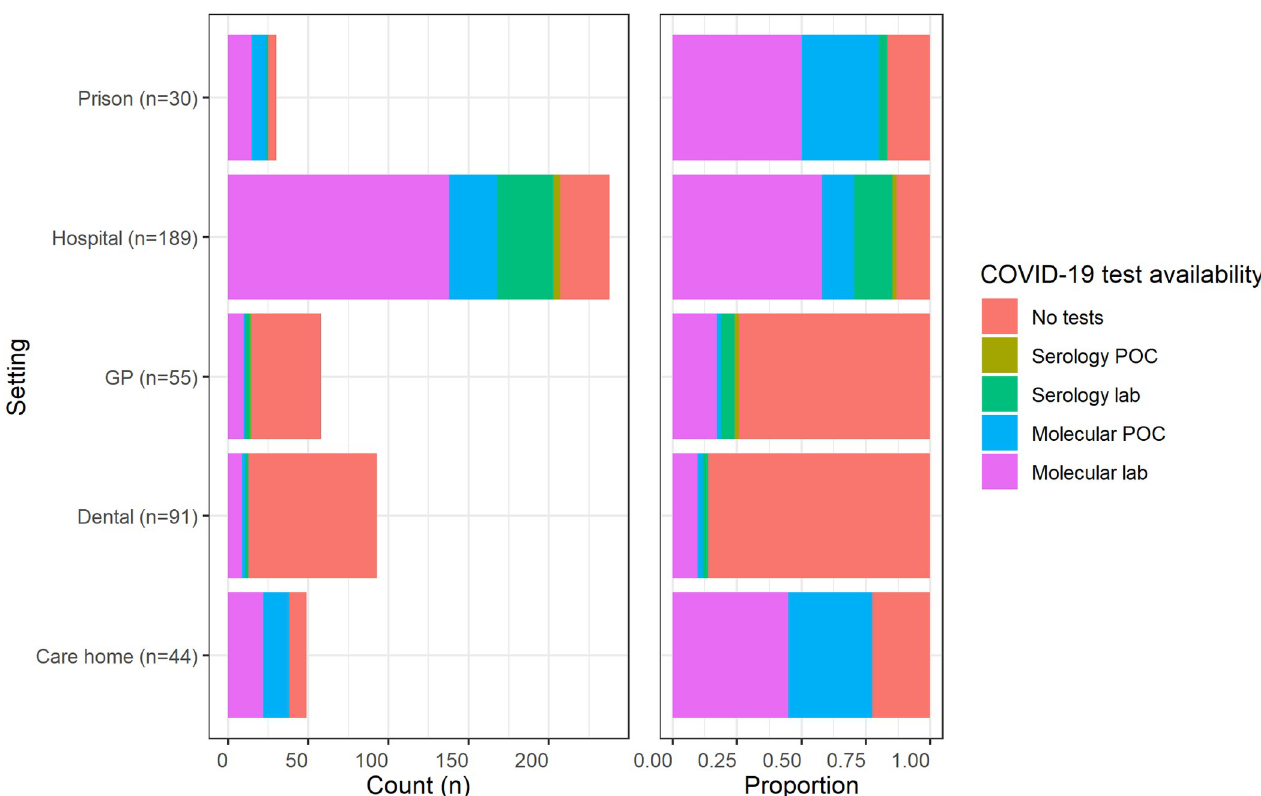
Fig 2. The availability of COVID-19 tests in each setting as reported by respondents. Primary and secondary dental settings were merged, in addition to care homes with and without nursing. The ‘Hospital-at-home’ (n = 3), hospices (n = 14) and ambulance setting (n = 9) were excluded due to the small number of overall respondents. Respondents were able to select multiple answers to this question. Plot key: ‘GP’ = ‘General Practice’; ‘POC’ = ‘Point of care’; ‘lab’ =